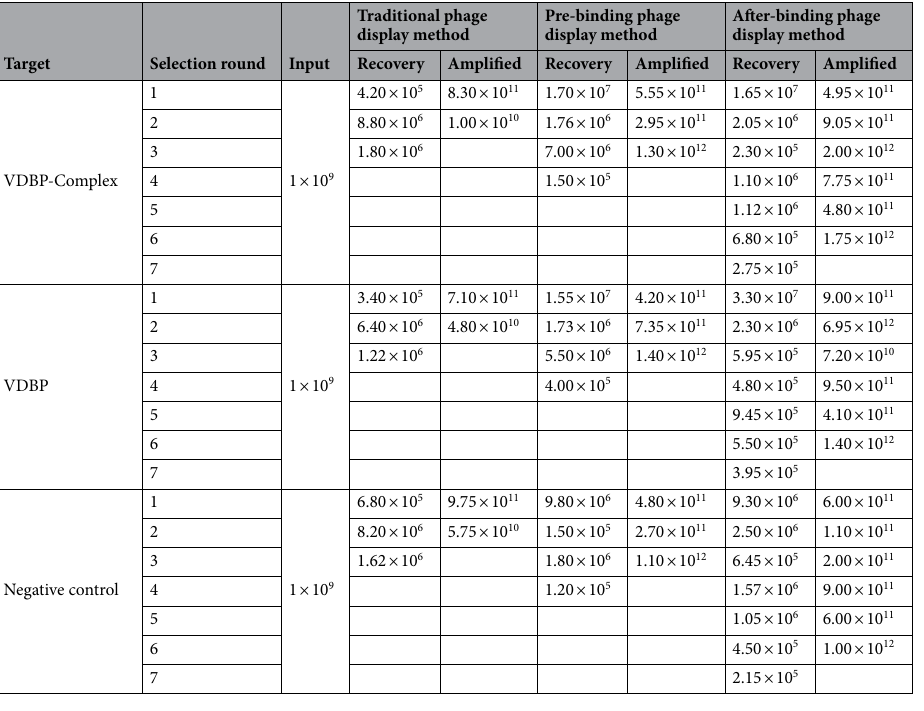
Table 1. Titration data of the recovery and amplified amount of phage after each phage display method (unit : pfu/mL). Summary of data calculated of the amount of phages recovered and amplified by the addition of the pre-binding method and after-binding method, compared to the existing phage display technique. For vitamin D binding protein complex (VDBP-Complex), vitamin D binding protein (VDBP), and empty petri dish (polystyrene used as negative control; NC), 3 rounds of biopanning were performed using the traditional method, 4 rounds using the pre-binding method, and 7 rounds using the after-binding method. The phage titer (pfu/mL) after each round was measured. pfu/mL plaque forming unit per milliliter; Negative control target uncoated plate (empty petri